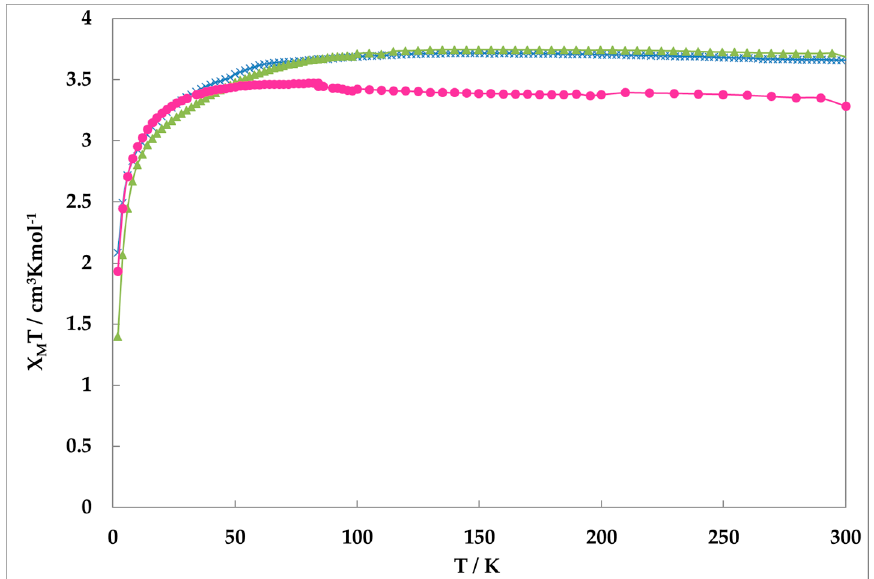
Figure 2. Magnetic susceptibility of 1 (red circle), 2 (green triangle), and 3 (blue cross).